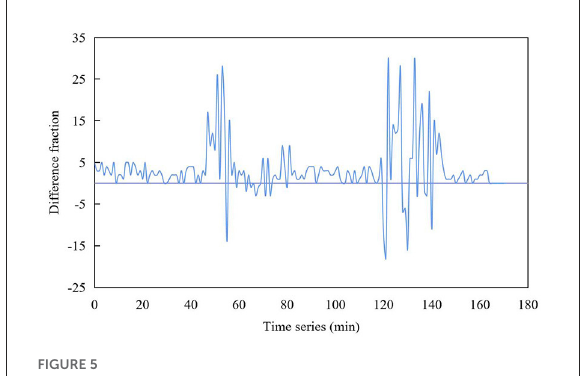
FIGURE5 Normalization result of network number.